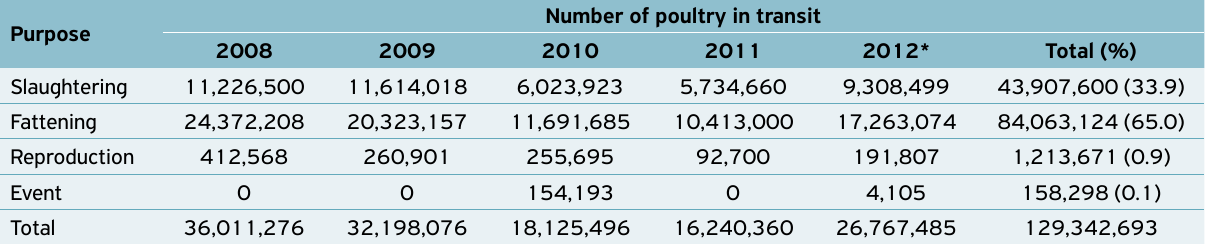
Table 3. Poultry transit clustered according to the purpose, Sergipe, Brazil,